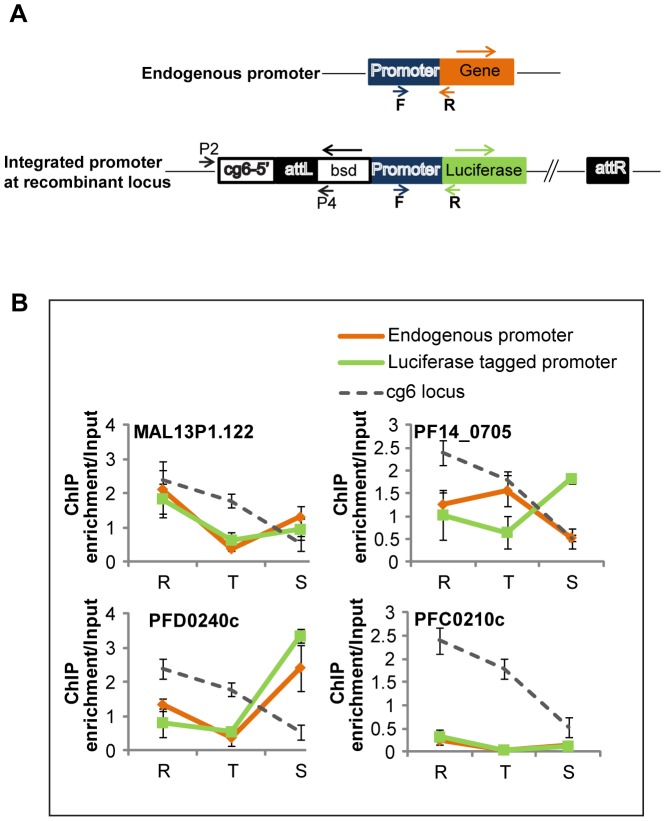
Histone modification patterns on ectopically integrated promoters.(A) Cloning strategy for ectopic integration of promoter regions. Four promoter regions (1.5–2 kb upstream of the ATG) corresponding to upstream regions of MAL13P1.122, PF14_0705, PFD0240c and PFC0210c were cloned upstream of the luciferase reporter gene pLN-luc (see Materials and Methods). P. falciparum strain Dd2attB was transfected with the above vectors to achieve integration at the cg6 locus and the transgenic cell lines were selected on blasticidin. Primer pair P2/P4 was used to confirm integration (data not shown). (B) H4K8ac occupancy at the four ectopically integrated promoter regions. The graphs represent real time PCR results carried out on H4K8ac-immunoprecipitated DNA from rings (R), trophozoites (T) and schizonts (S). In order to distinguish between the endogenous and luciferase tagged promoter, specific primers were designed to amplify regions spanning the 3′ end of the promoter and either the start of the endogenous gene or the start of the luciferase gene. The positions of forward (F) and reverse (R) primers are shown in panel A. Grey lines refer to the ChIP enrichment of the native cg6 locus in the untransfected parasites. Orange and green lines represent the ChIP enrichment of native promoters and integrated promoters, respectively, in the transfectants. The error bars give the standard deviation from triplicate experiments.